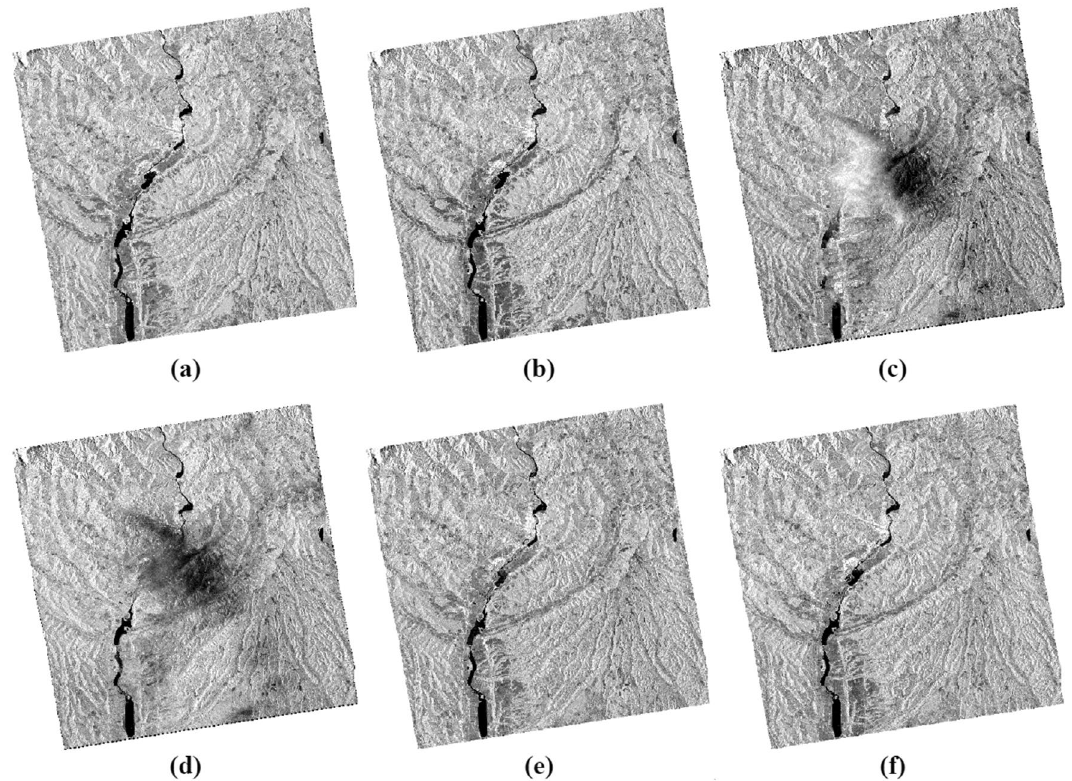
Figure 3. Amplitude images of the study area at different dates and different polarization, with the resolution of 10 m, calibrated, geo-referenced, ortho-rectified and filtered, ( a ) σ0 VV (db), 14/05/2020; ( b ) σ0 VH (db), 14/05/2020; ( c ) σ 0 VV (db), 20/05/2020; ( d ) σ 0 VH (db), 20/05/2020; ( e ) σ0 VV (db), 01/06/2020; ( f ) σ0 VH (db),